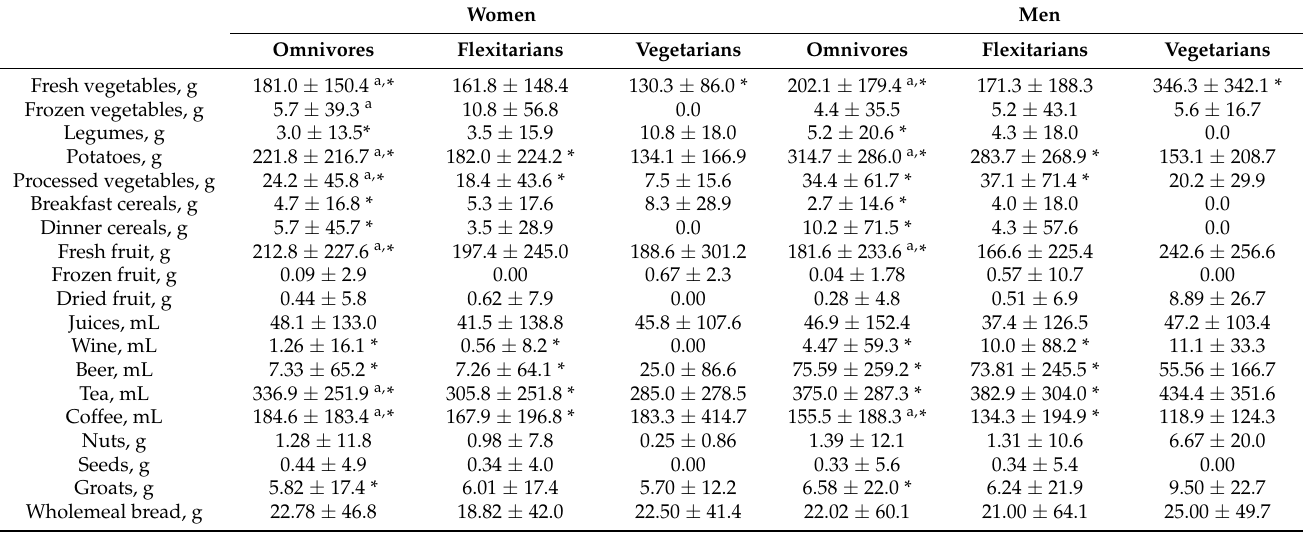
Table 3. Daily intake of selected food items containing antioxidants according to the dietary patterns of the study